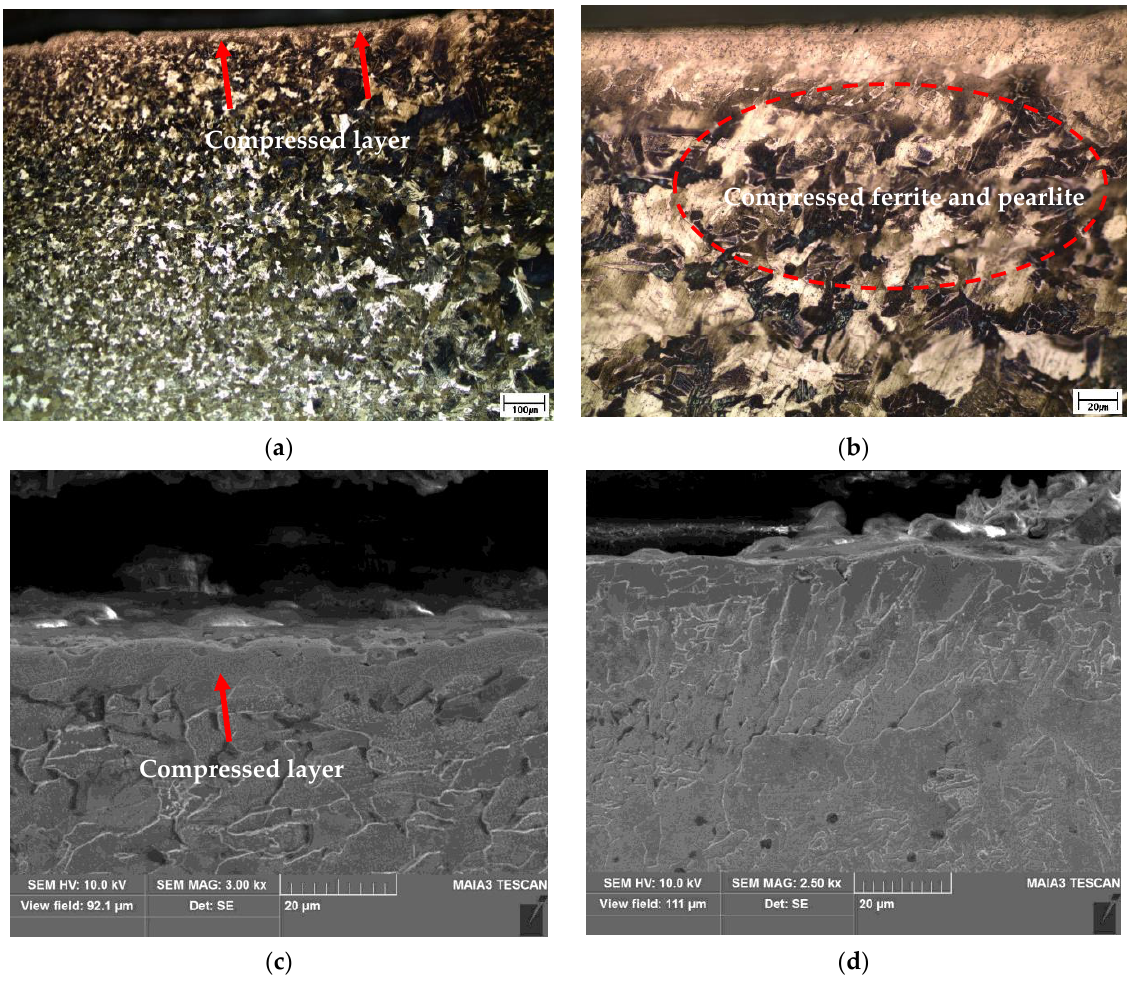
Figure 7. Microstructure of peened overlap-defect specimen. ( a ) Low-magnification optical image of the HAZ; ( b ) High-magnification optical image of the HAZ; ( c ) Scanning electron microscopy (SEM) image of the HAZ; ( d ) SEM image of the weld bead.